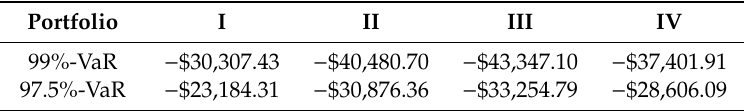
Table 6. Undiversified Portfolio